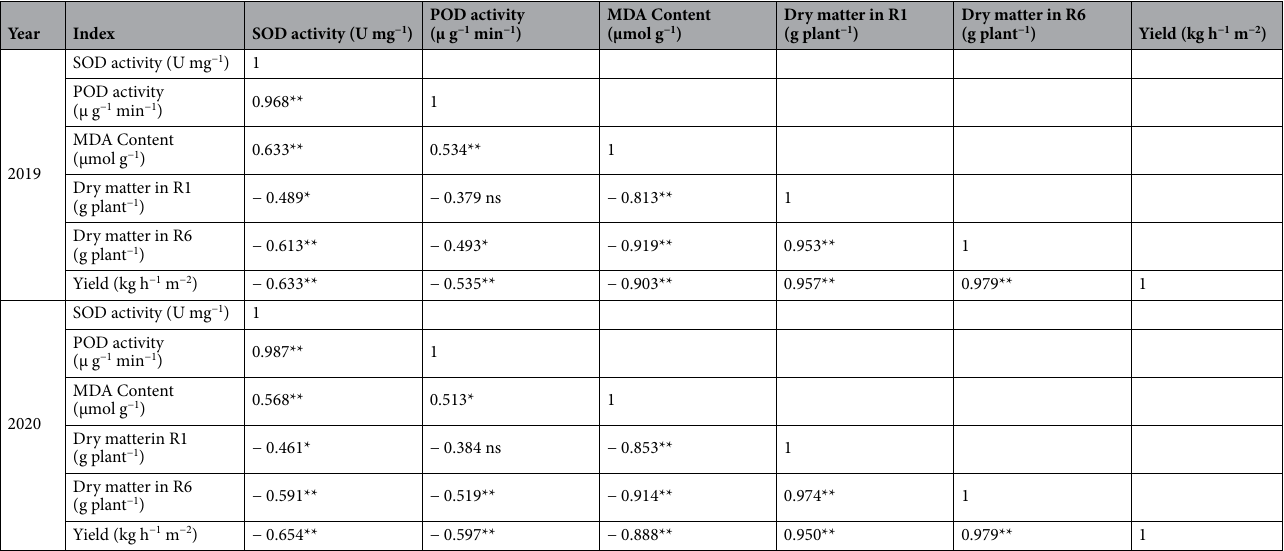
Table 3. Correlation analysis of endogenous protective enzymes, dry matter accumulation and yield of